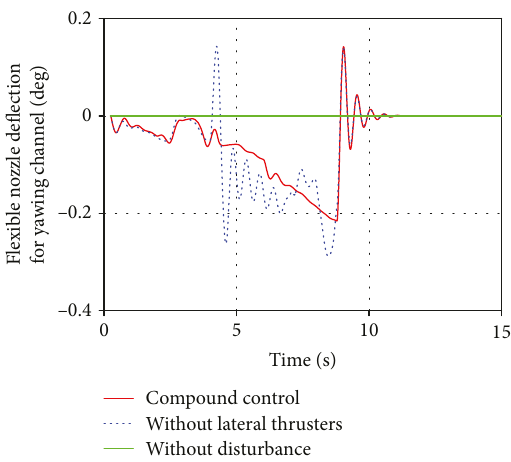
Figure 6: Variation of nozzle de fl ection for yawing channel in the initial stage of launch.